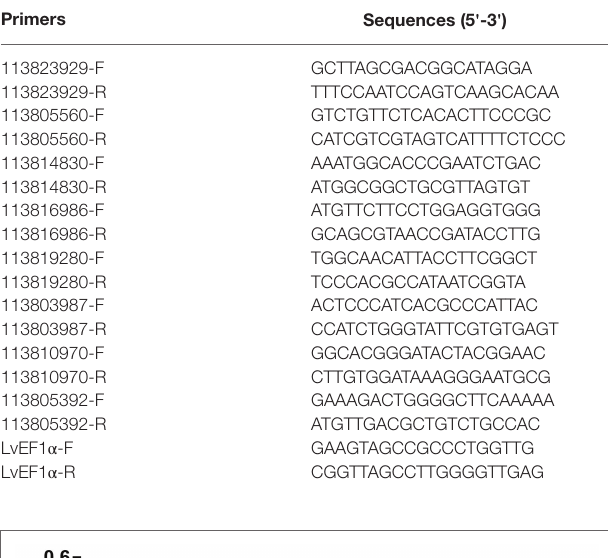
TABLE 2 | PCR primers used in this study.